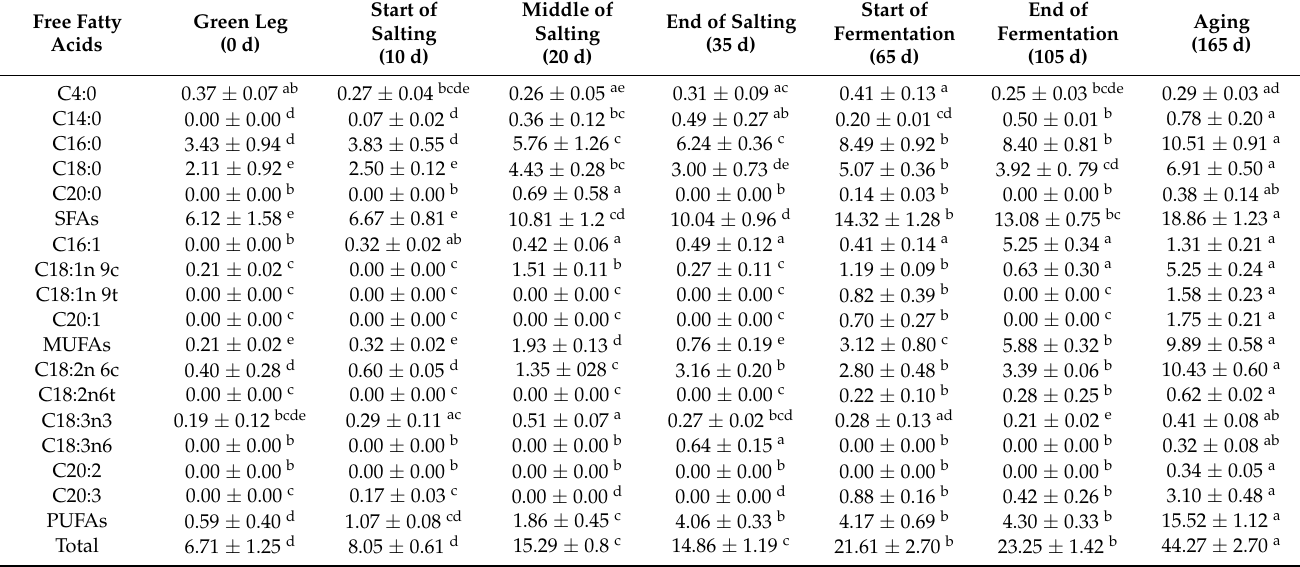
Table 3. Changes of free fatty acids in samples during the processing of dry-cured donkey leg